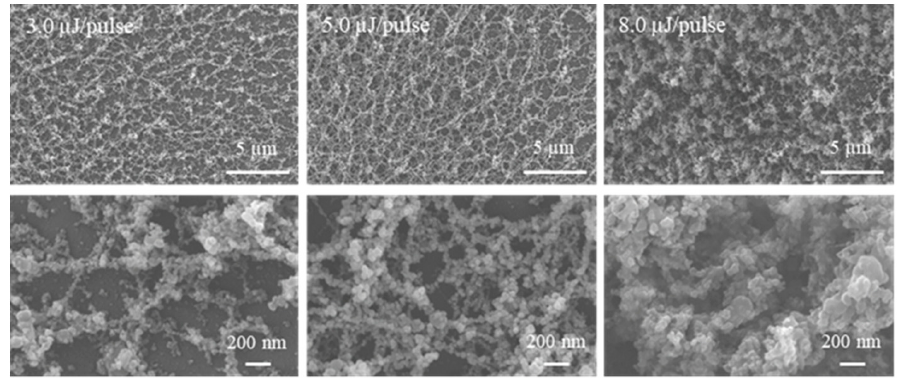
Figure 5. SEM images of NPs on glass slides after fs laser irradiation with different pulse energies.